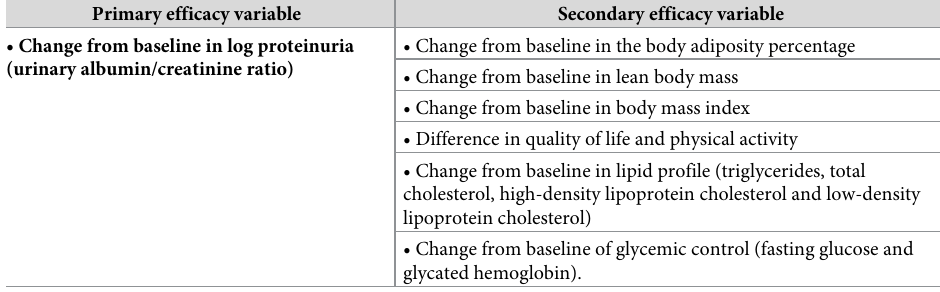
Table 1. Description of the primary and secondary efficacy variables for patients who have received a KTx and participated in the